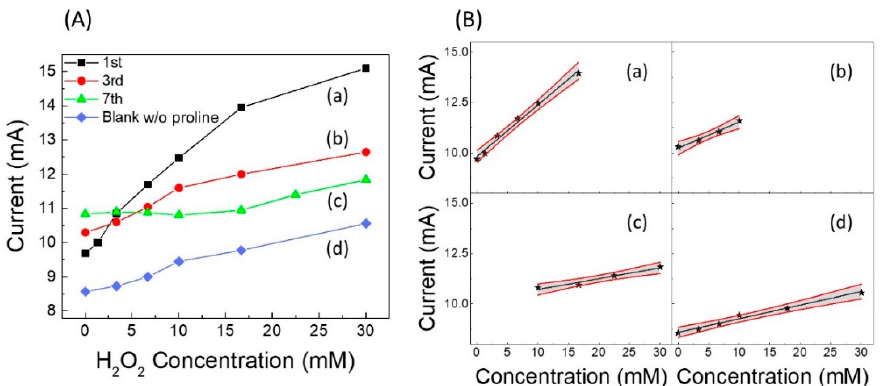
Figure 3. ( A ): (a–c) calibration curves vs. H 2 O 2 concentration as a function of lifetime (about a week), reading the current peak at − 0.58 V, and (d) “blank” curve without proline. ( B ) Calibration straight-lines (black) and confidence limits (red) at the (a) 1st day, (b) 3rd day, (c) 7th day, and (d) blank without proline. Each point (i.e., star symbol) is the mean of at least three determinations.